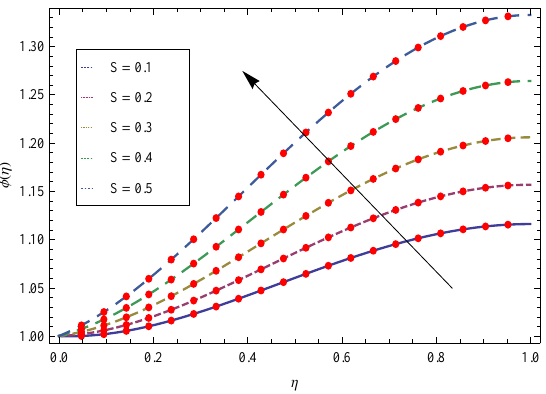
Figure 6. Variations in the Temperature gradient θ ( η ) for different values of S , when h = − 0.8, λ = 0.1, kr = 0.5,Pr = 0.5,Ec = 0.5,Nb = 0.5,Nt = 0.6, β = 1, Sc = 0.6.